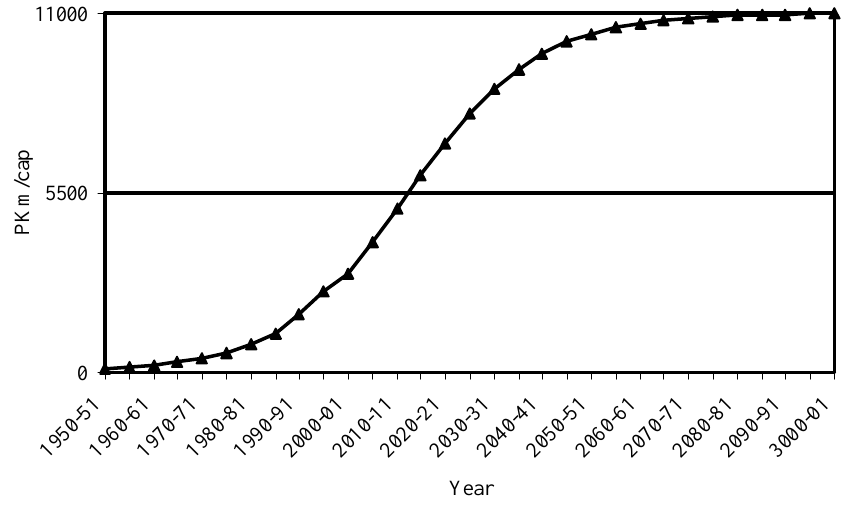
Figure 1. Projected path of road-based per capita passenger mobility in India